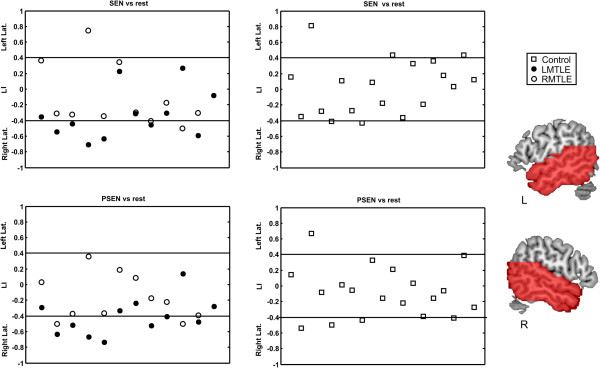
Individual LIs for each participant and for both SEN vs. Rest and PSEN vs. Rest contrasts. LIs under -0.4 are considered right lateralized, with LIs being larger than 0.4 being considered left lateralized. LIs between -0.4 and 0.4 are considered bilateral. On the right side the ROIs used to calculate the LIs are overlaid on red over a canonical MNI template. PSEN, Passive Listening to Pseudo Sentences; SEN, Passive Listening to Sentences; LMTLE, Left Temporal Lobe Epilepsy; RMTLE, Right Temporal Lobe Epilepsy; L, Left Hemisphere; R, Right Hemisphere.